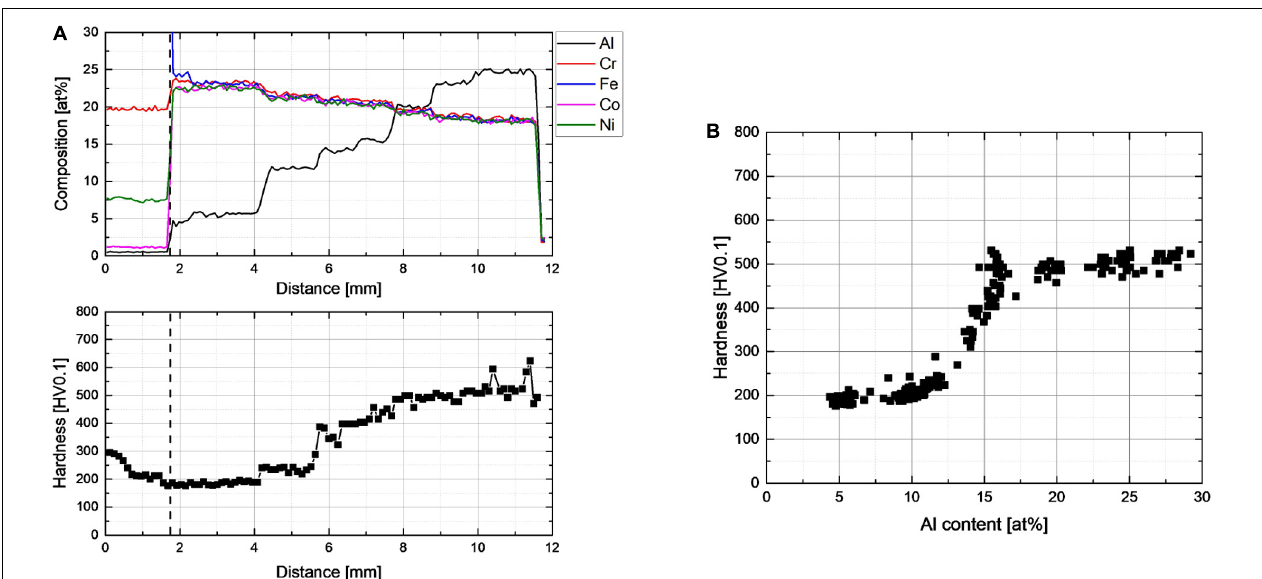
FIGURE 5 | Chemical composition and hardness of the 5/15/25 at% Al as built gradient structure (A) ; hardness as a function of Al content derived from all three as built gradient structures (B) .